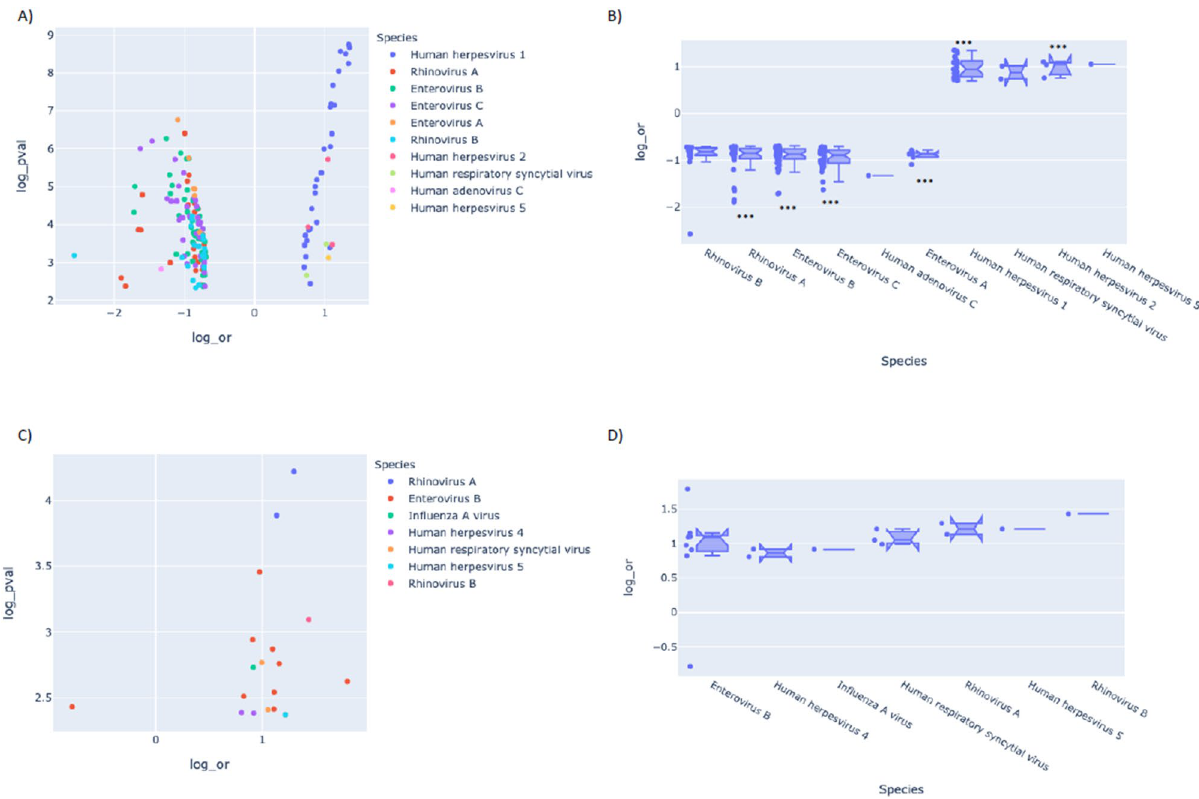
Figure 4. Viral peptides differentially enriched in the obese populations. Enriched peptides of the VirScan phage display library that were positively or negatively associated with obesity with a minimum odds ratio of 2 (= ± 0.693 in log scale) with significance threshold i.e. 0.005 (= 2.9 for − Log(p-value)) are plotted. Volcano plots showing the distribution of differentially enriched peptides based on their OR and p-values in ( A ) the adult population and in ( C ) the pediatric population. Violin plots showing the differentially enriched peptides grouped under viral species with their OR and 95% CI in ( B ) the adult population and in ( D ) the pediatric population. ***Peptides that passed significance threshold after Bonferroni correction ( p < 3.61E −